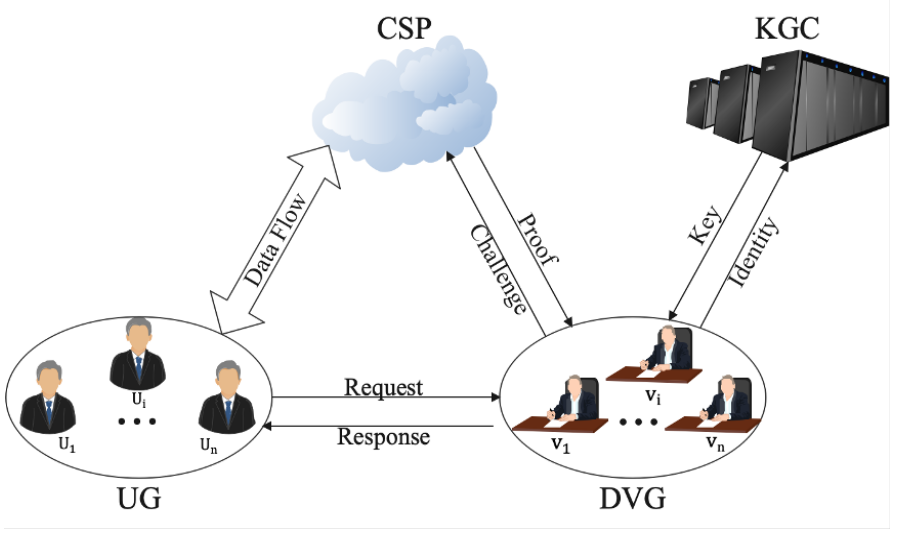
Figure 1. System